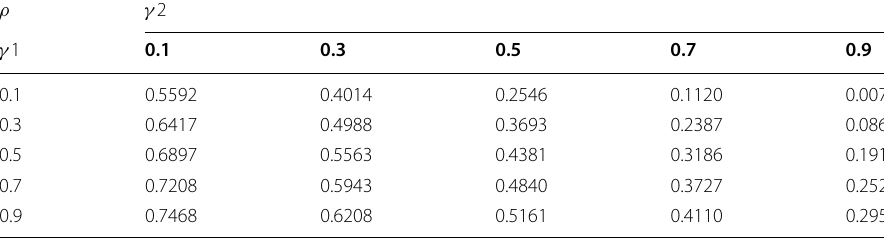
Table 3 Relationship among PS ratio, secrecy rate of user 1, secrecy rate of user 2